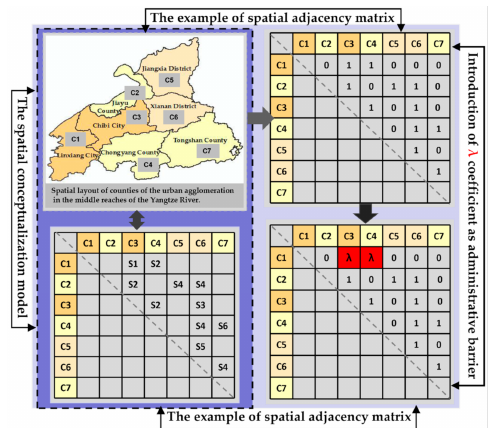
Figure 3. Conceptual model of the spatial adjacency matrix. Note: Chibi City is a county-level city administered by Xianning city of Hubei province. Linxiang City is a county-level city administered by Yueyang City of Hunan province. Jiayu County, Chongyang County, and Tongshan County